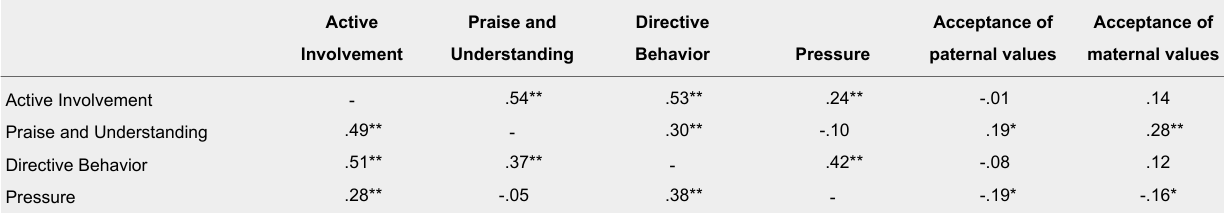
Active Praise and Directive Involvement Understanding Behavior Pressure